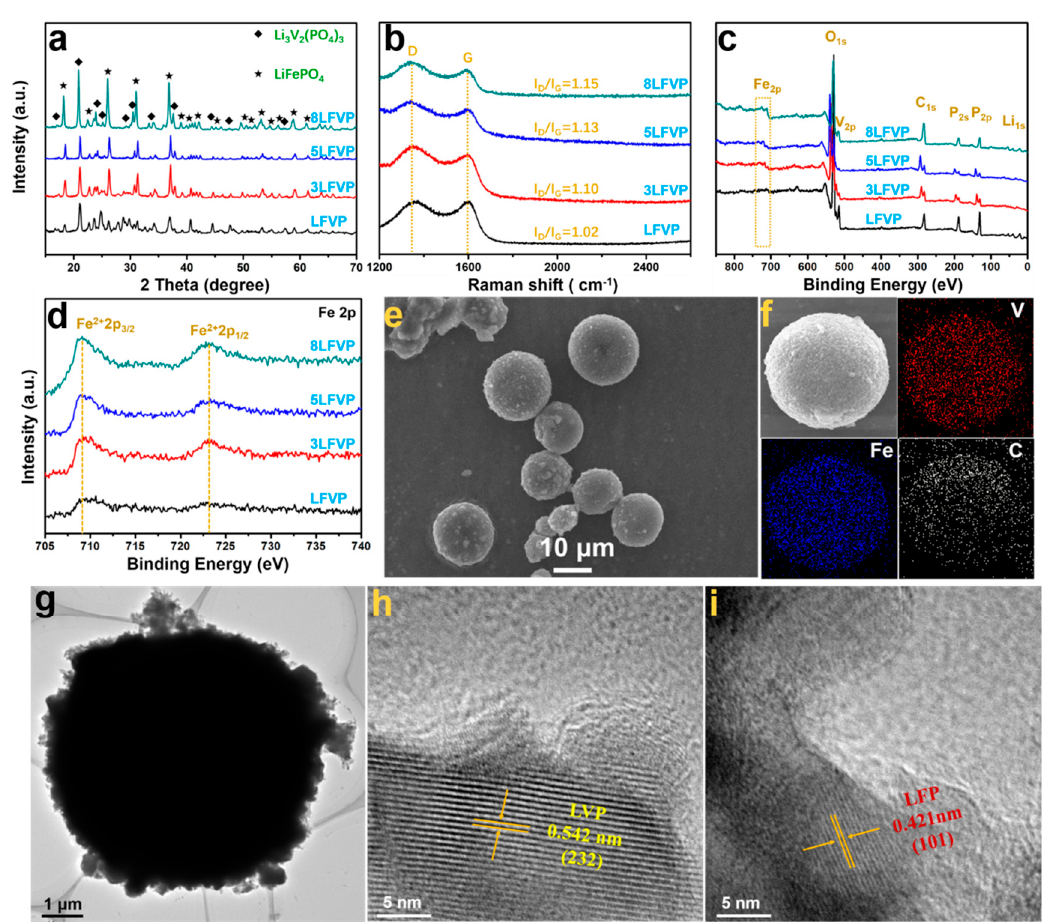
Figure 1. ( a – c ) XRD patterns, Raman spectra, and full XPS spectra of the series of xLFP·yLVP composites; ( d ) Fe 2 p fine spectrum of xLFP·yLVP composites; ( e , f ) SEM images of 8LFVP/C with EDS mapping; ( g ) TEM of 8LFVP; ( h , i ) HRTEM of 8LFVP with the lattice spacings of LVP and LFP.